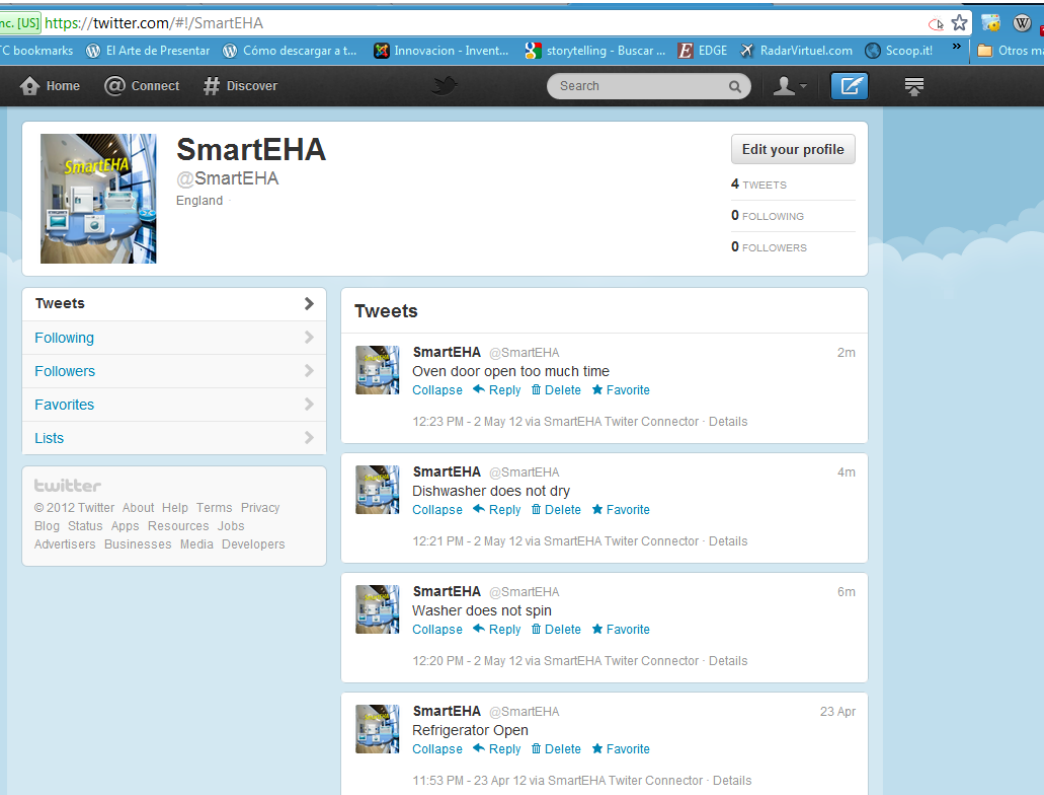
Figure 12. Several tweets in the SmartEHA account in